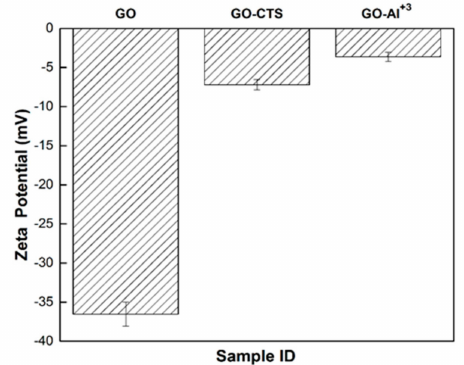
Figure 3. The ζ potential for GO-cross-linked composites at pH ~6 and 295